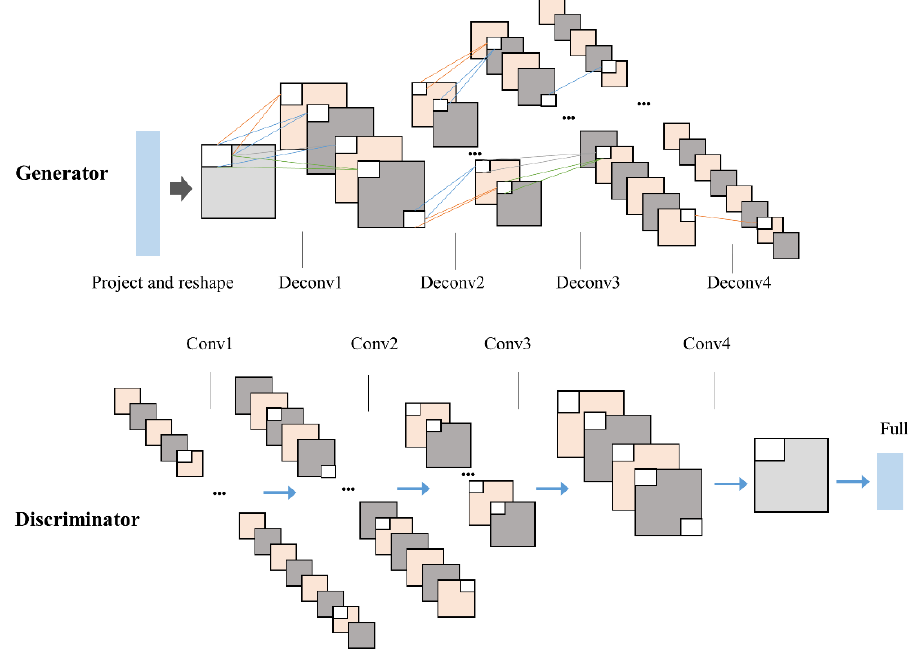
Figure 4. The structure of the DCGANs.